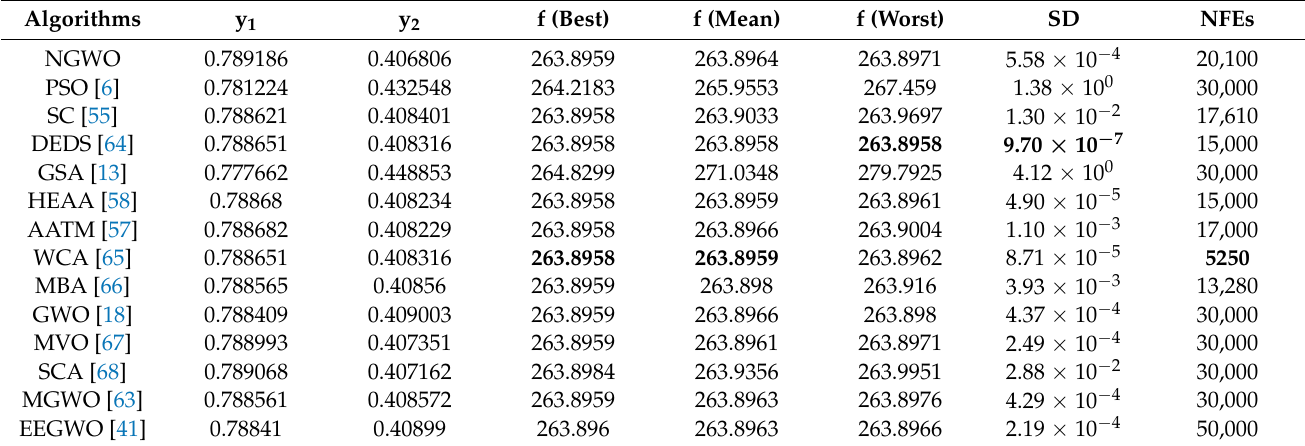
Table 8. Results of three bars truss design